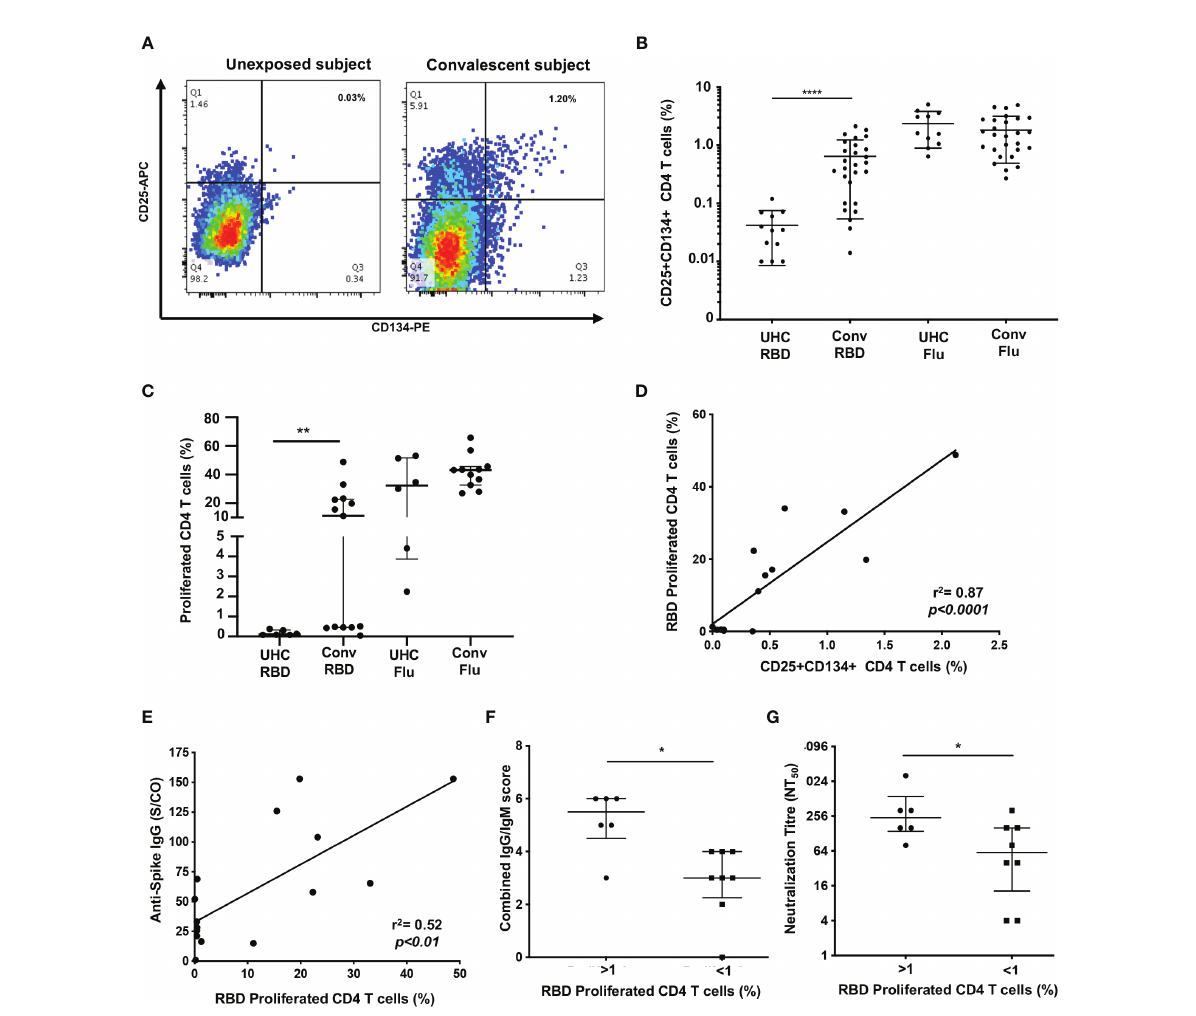
FIGURE 1 Proliferation of SARS-CoV-2 reactive CD4+ T cells correlate with antibodies. (A) Representative dot plots of CD25+CD134+ co-expression on RBD-speci fi c CD4+ T cells. (B) Frequency of RBD reactive CD4+ T cells in convalescent subjects (conv) compared to unexposed healthy controls (UHC). (C) Percentage of proliferating CD4+ T cells stimulated with RBD or Flu antigen. (D) Positive correlation between recall CD25 +CD134+ CD4 response and 7 days of proliferation. (E) Correlation between spike IgG levels and RBD speci fi c proliferation of CD4+ T cells. (F) Convalescent subjects with proliferated CD4+ T cells (>1%) are Ab high vs subjects without proliferation (<1%) are Ab low, based on combined IgG/IgM score. (G) Subjects with proliferated CD4+ T cells (>1%) have signi fi cantly higher neutralizing Ab titres (NT 50 ) vs subjects without proliferation (<1%). Data shown as medians with interquartile ranges. Two-tailed p values <0.05 were considered signi fi cant (*<0.05, **<0.01, ***<0.001, ****<0.0001). Mann-Whitney T tests were used for unpaired groups and Pearson ’ s rho was used for